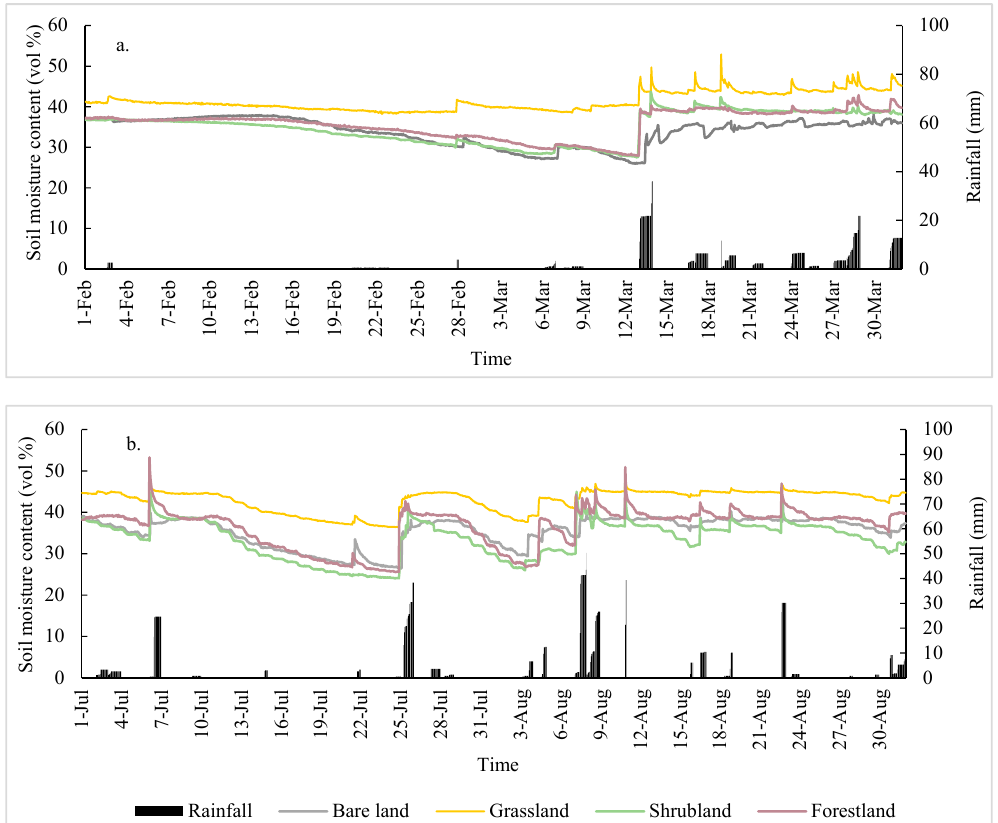
Figure 4. Temporal variations in volumetric soil moisture content with rainfall for the dry ( a ) and the rainy ( b ) season. Table 3. Meteorological data of the dry and rainy seasons.